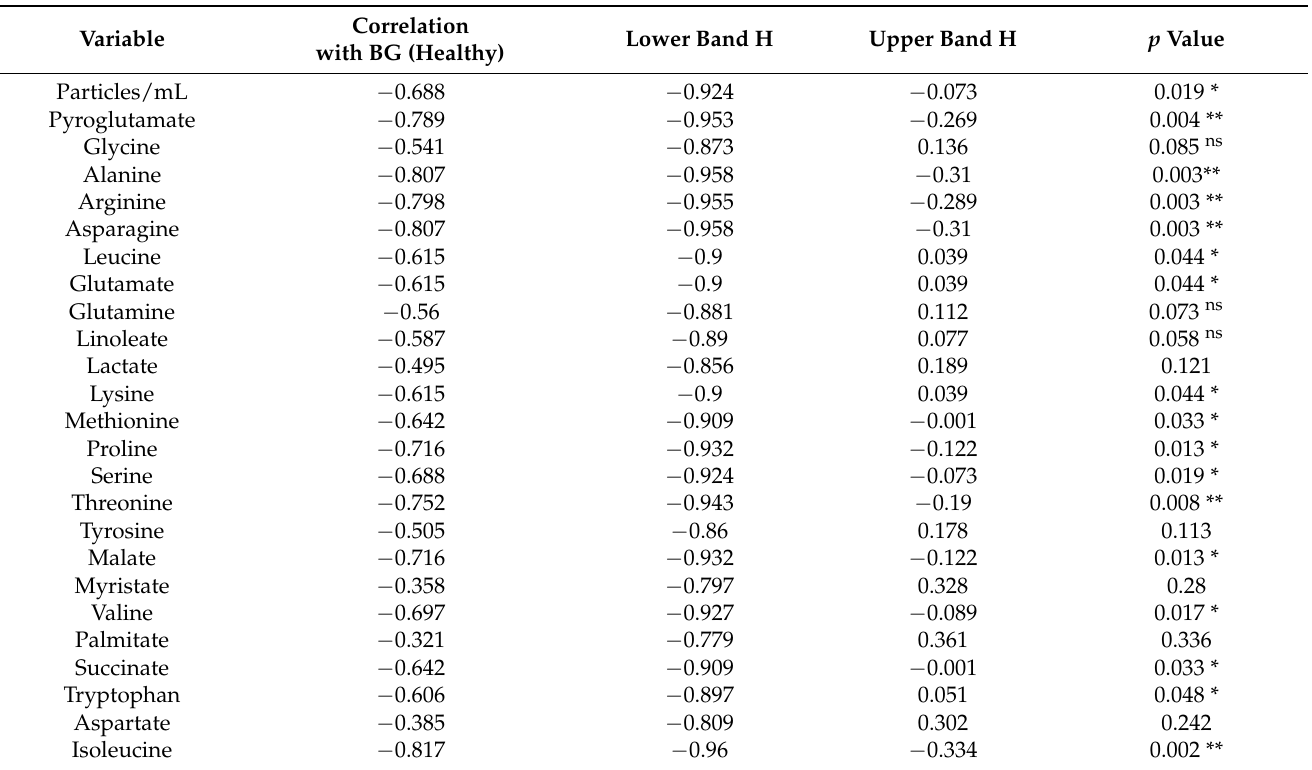
Table 4. Spearman’s rank correlation between blood glucose and metabolite levels in the EVs isolated from healthy control participants. * p < 0.05 and ** p < 0.005 are significant. ns. not